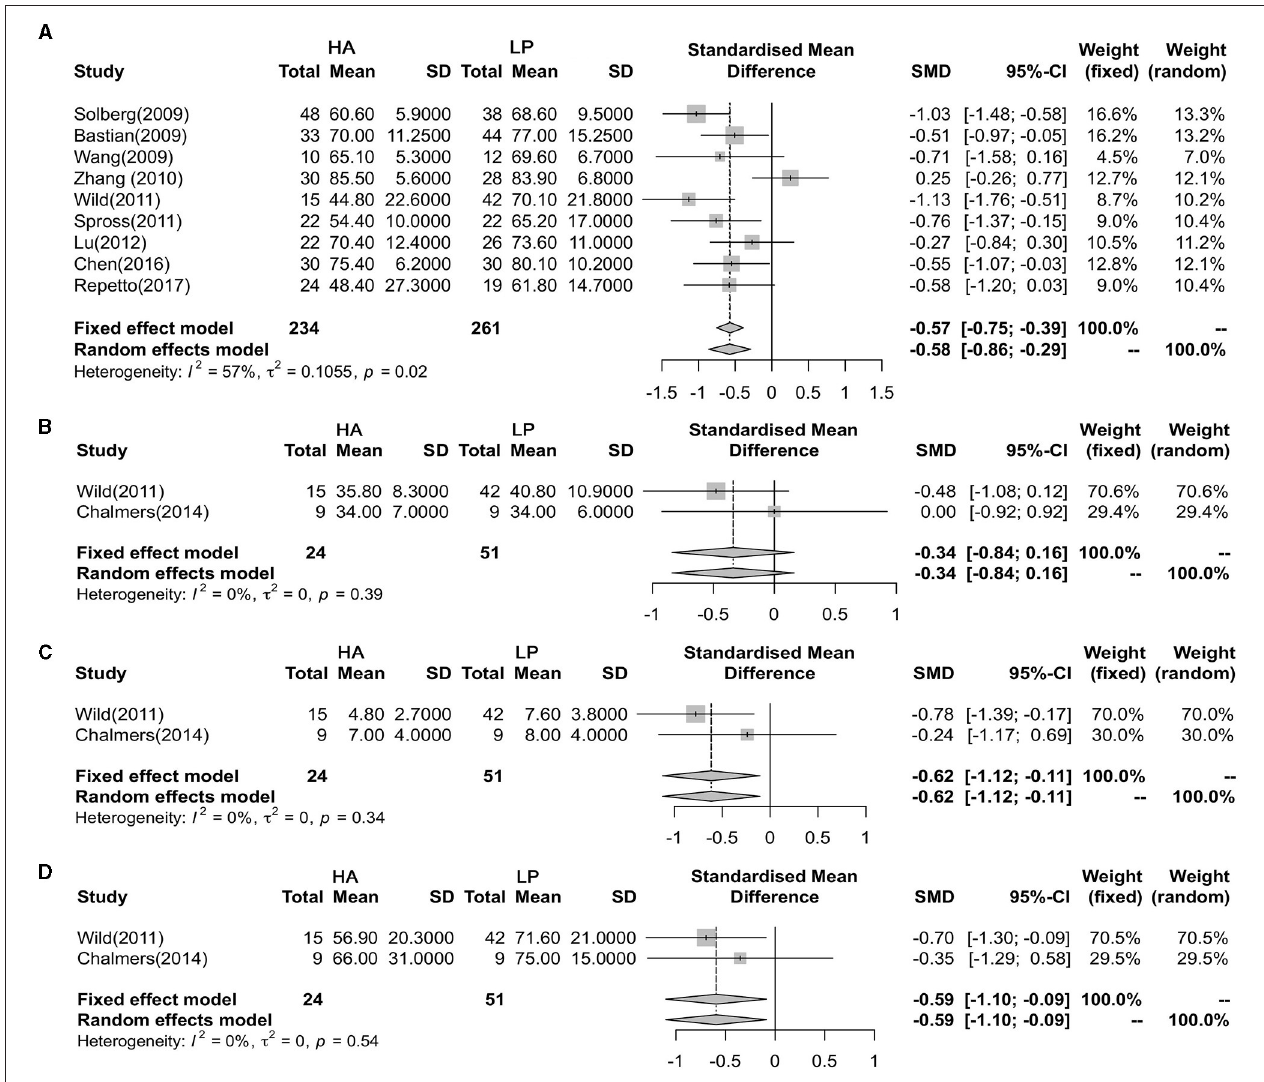
FIGURE 4 | Forest plot showing the meta-analysis of the functional outcome. (A) Constant-Murley score (CMS); (B) Short Form Health Survey (SF-12V2); (C) Simple Shoulder Test (SST); (D) American Shoulder and Elbow Surgeons Score